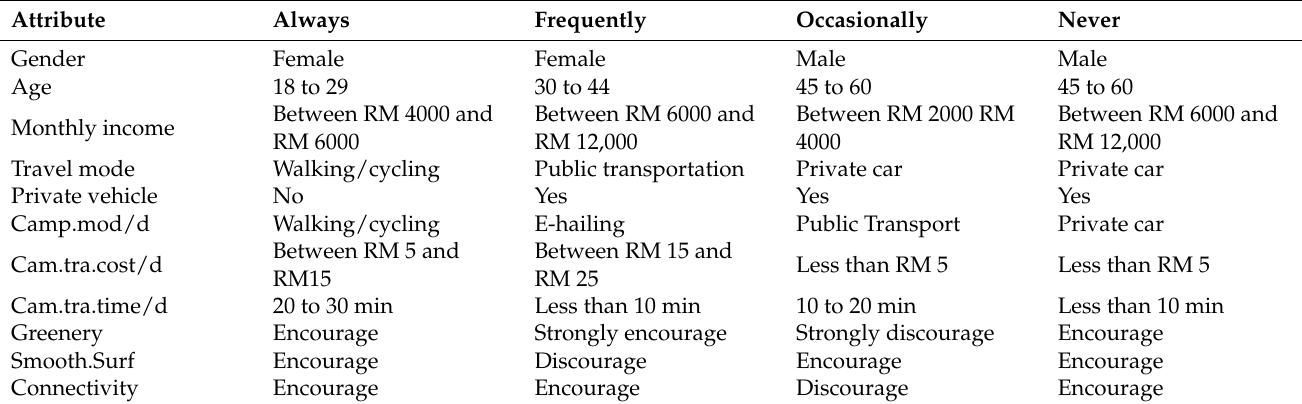
Table 7. Optimized value of attributes based on four